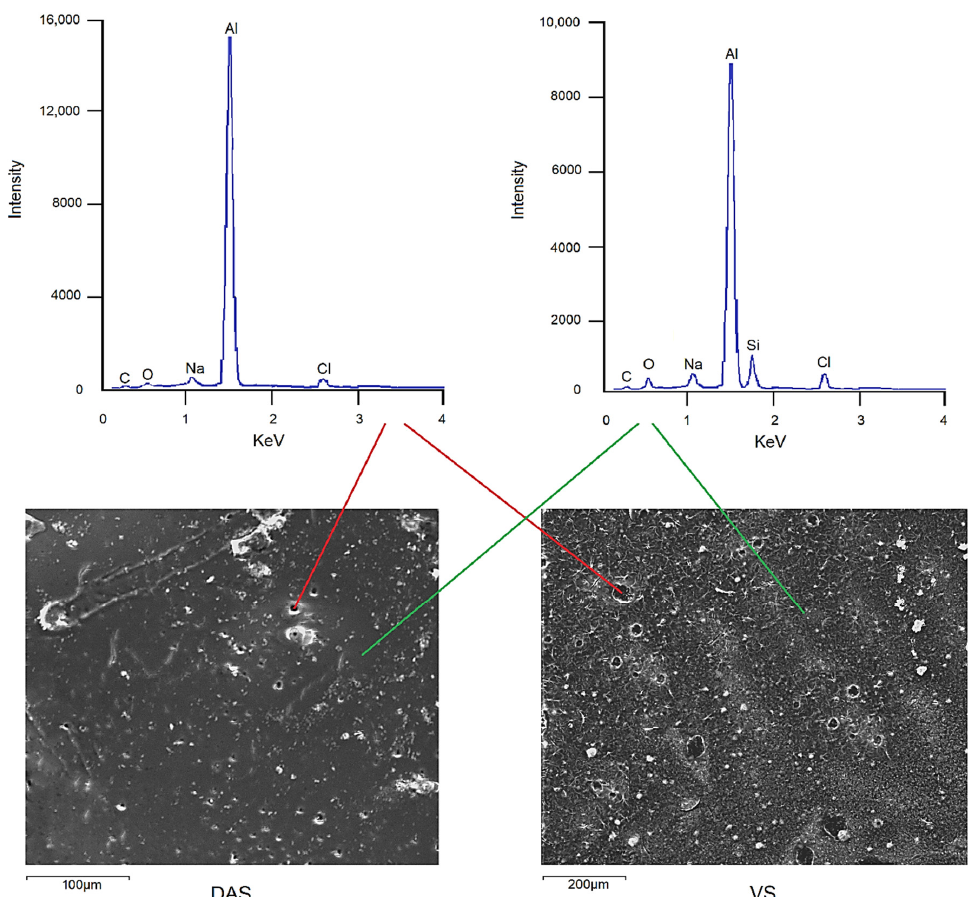
Figure 6. Microphotography of diaminsilane and vinyltrimethoxysilane films and EDS spectra on the surface of Al after the influence of anodic polarization in a solution of 0.4 M H 3 BO 3 + 0.1 M Na 2 B 4 O 7 + 0.01 M NaCl pH 6.7.